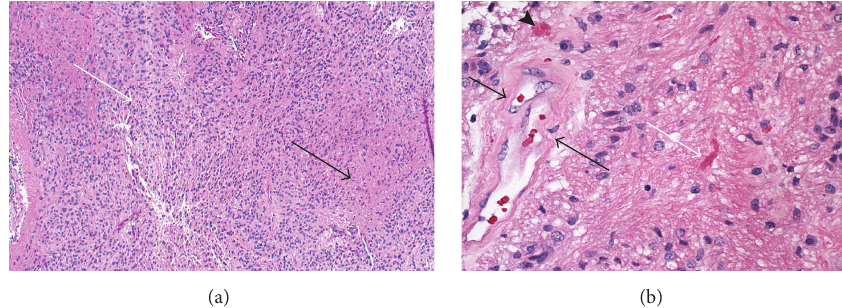
Figure 3: (a) H&E, mag × 100, cellular glial neoplasm composed of intermingled ependymal component (white arrow) and eosinophilic fibrillary component (black arrow). (b) H&E, mag × 400, both components of the lesion, pseudorosette on the left (black arrows) and fibrillary component with numerous Rosenthal fibers on the right, with the largest Rosenthal fiber in the center (black arrow). An eosinophilic body is seen on the left, above the vessel (arrowhead).